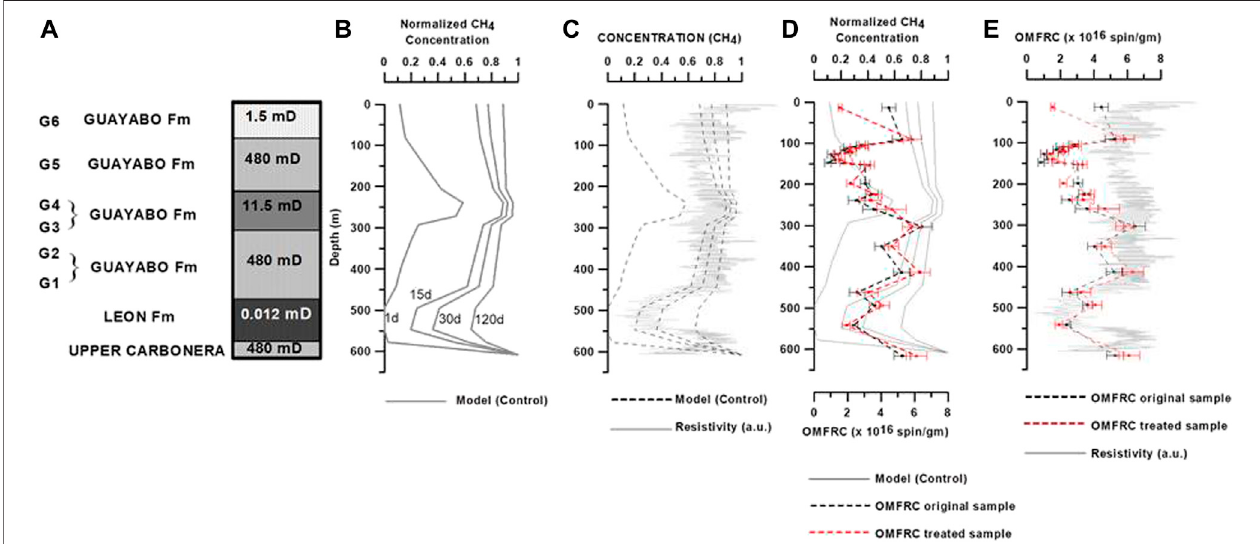
FIGURE 10 | Stratigraphic well Saltarin 1A: (A) Arrangement of sedimentary layers for the control sequence featuring maximum permeability values. (B) Numerical results of methane distributions versus depth for timespans of 1, 15, 30, and 120 days. (C) Resistivity type-log (arbitrary units) of the Eastern Llanos Basin (from Figure 2B after Barrero et al., 2007) correlated with the stratigraphic sequence of Saltarin 1A and compared with the numerical results of methane distributions versus depth. (D) OMFRC for both chloroform-treated and untreated samples compared with the numerical results of methane distributions versus depth. (E) Resistivity type-log for the Eastern Llanos Basin compared with the OMFRC pro fi